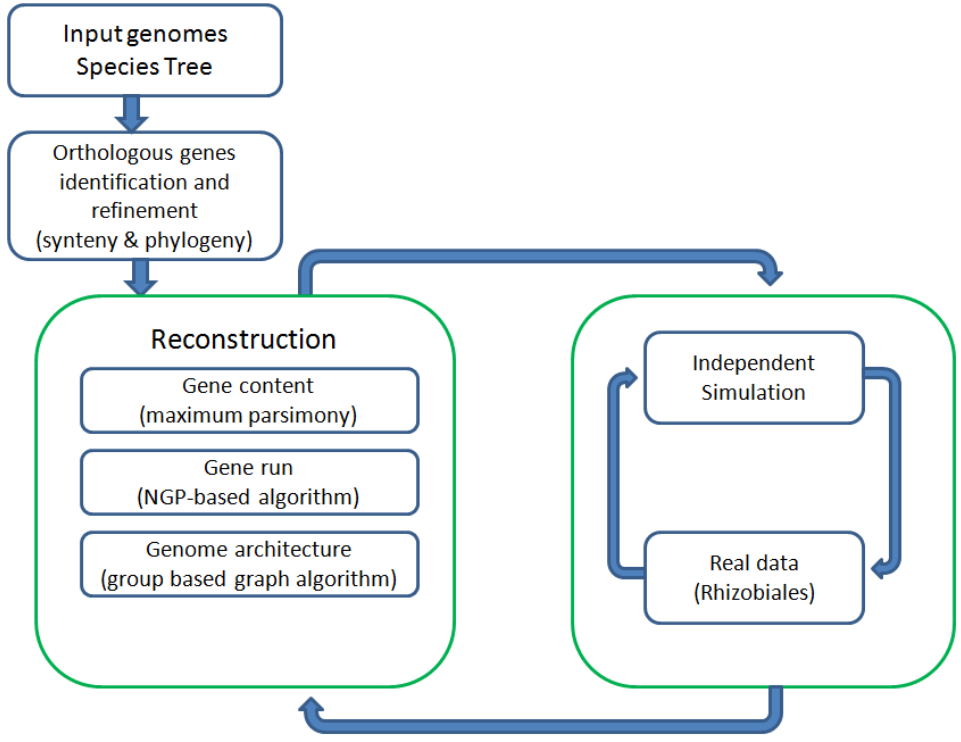
Figure 1. Overview of all major components in